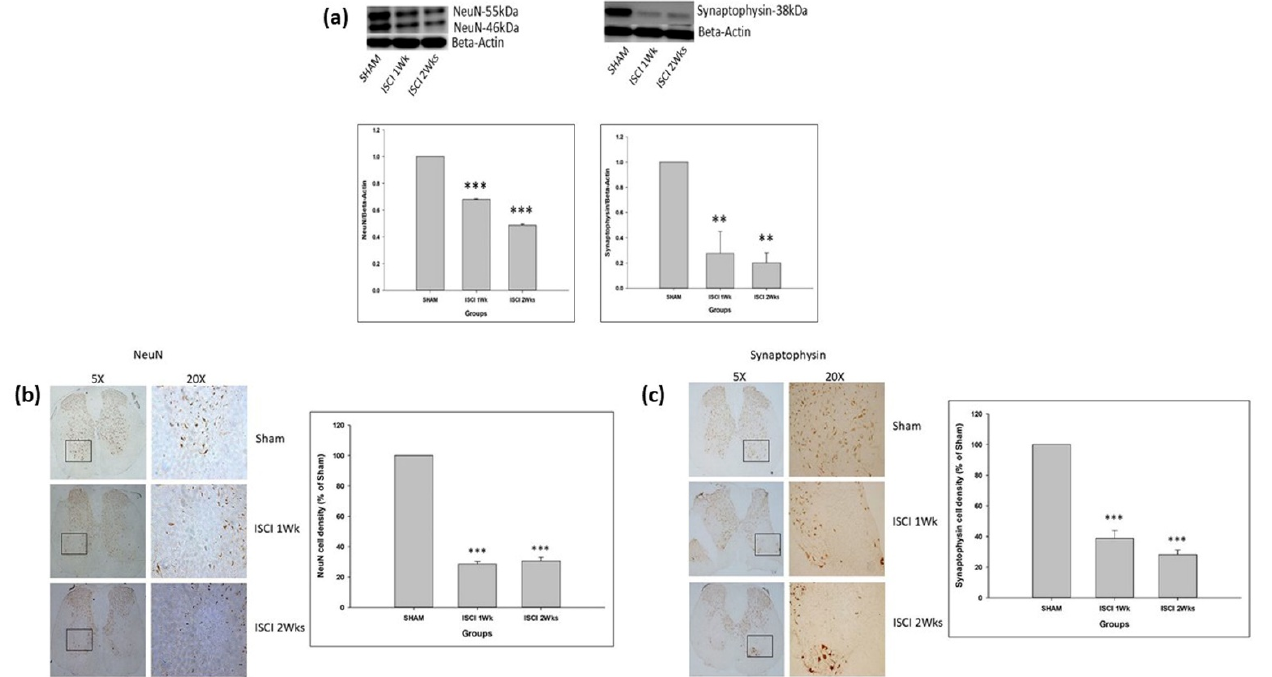
Figure 6. ( a ) Western blot images with the quantification results showing NeuN and synaptophysin; ( b ) Immunohistochemistry images with the quantification results showing the NeuN positive cells; ( c ) Immunohistochemistry images with the quantification results showing the synaptophysin positive cells. Data are expressed as mean ± standard error. ** p < 0.01 versus the sham group; *** p < 0.001 versus the sham group.